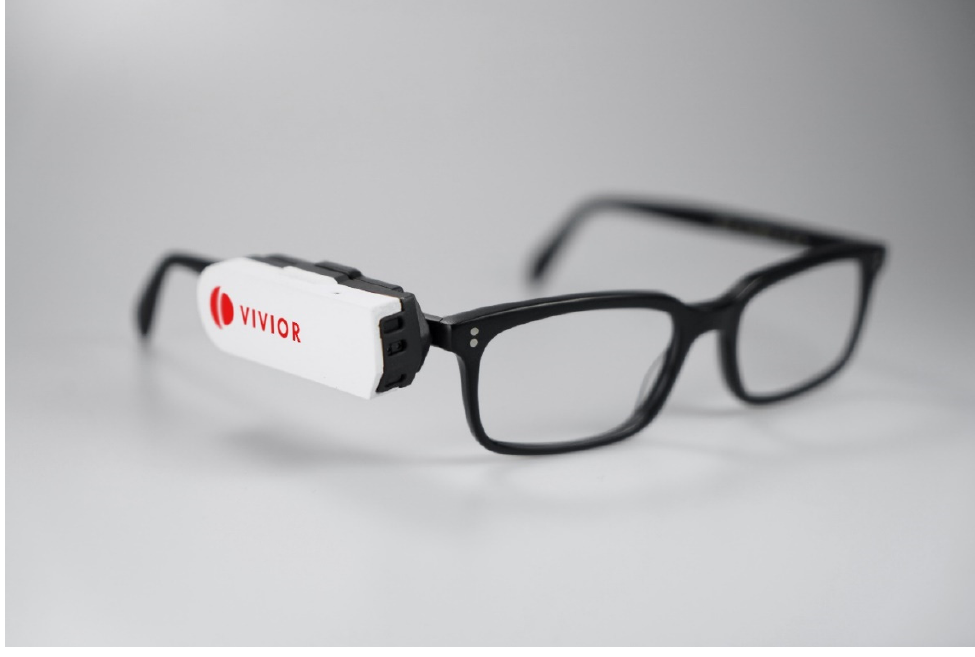
Figure 1. Visual Behavior Monitor (VBM) fixed on the spectacles.